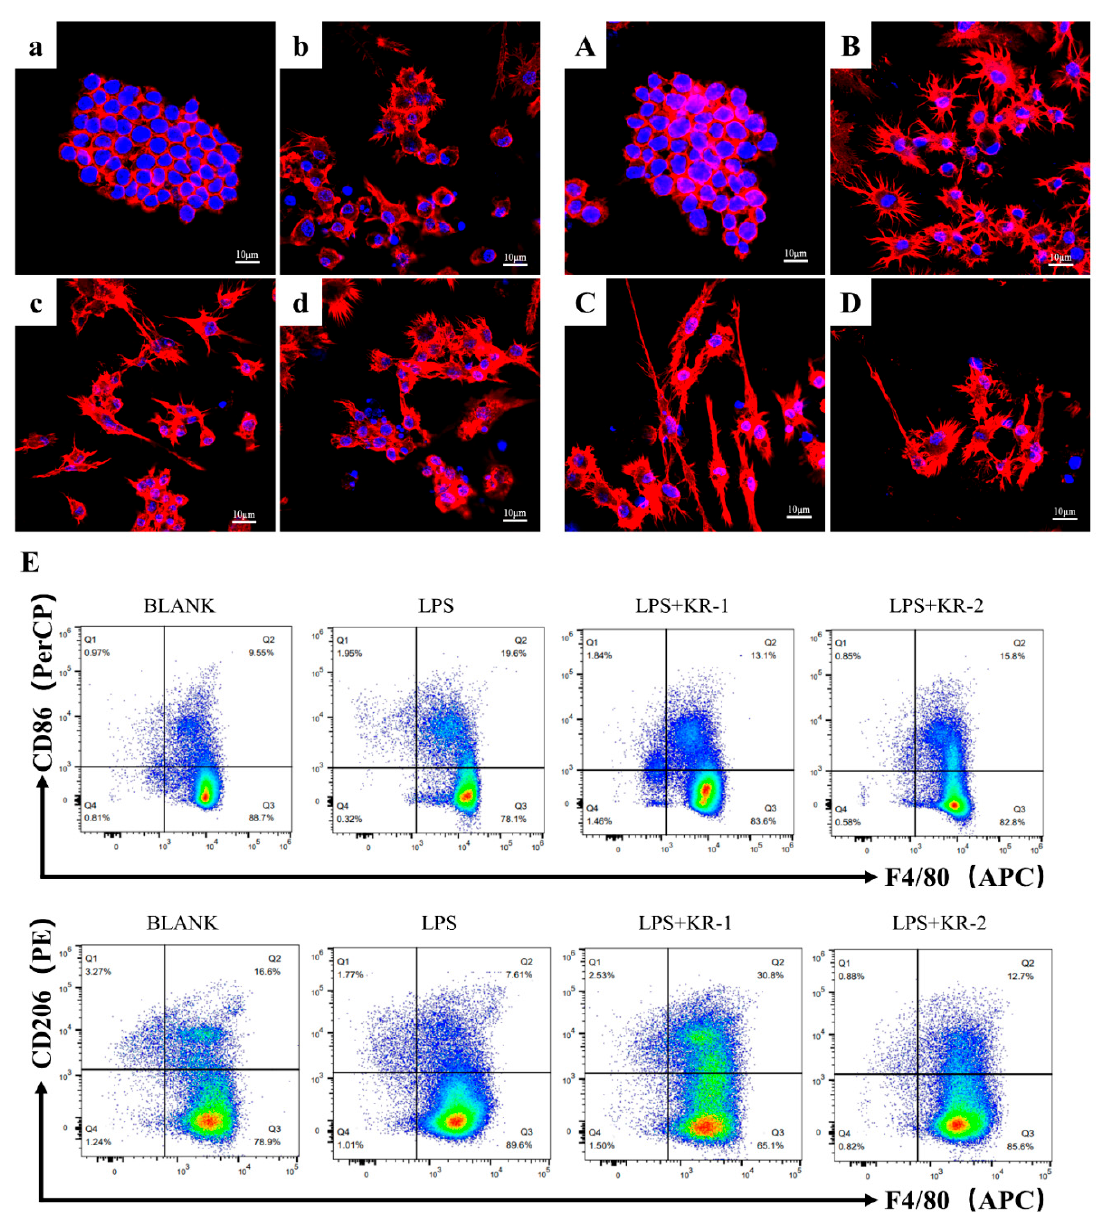
Figure 5. Regulation of macrophage phenotype in vitro. NOTE: CLSM images ( a – d , A – D ), lowercase letters represent images from day 1 and uppercase letters represent images from day 3. ( a , A ) BLANK control group. ( b , B ) LPS treatment group. ( c , C ) KR − 1 and LPS were added at the same time. ( d , D ) KR − 2 and LPS were added at the same time. ( E ) F4/80 + /CD86 + and F4/80 + /CD206 + cells detected by flow